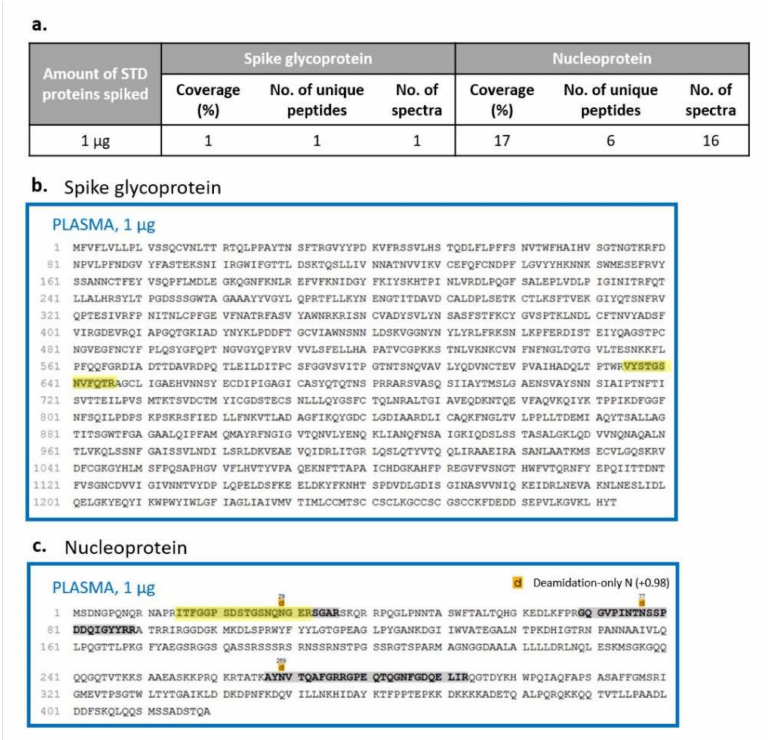
Figure 8. Sequence coverage of the spike glycoprotein and the nucleoprotein in plasma (pre-digestion). Summary table of the results obtained by spiking plasma samples with 1 µ g of each purified SARS- CoV-2 protein (S1, S2, RBD and N) before digestion ( a ). Peptides identified for the spike